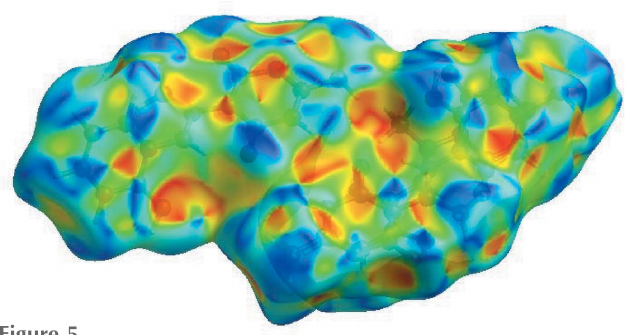
Figure 5 Hirshfeld surface of the title compound plotted over shape-index.